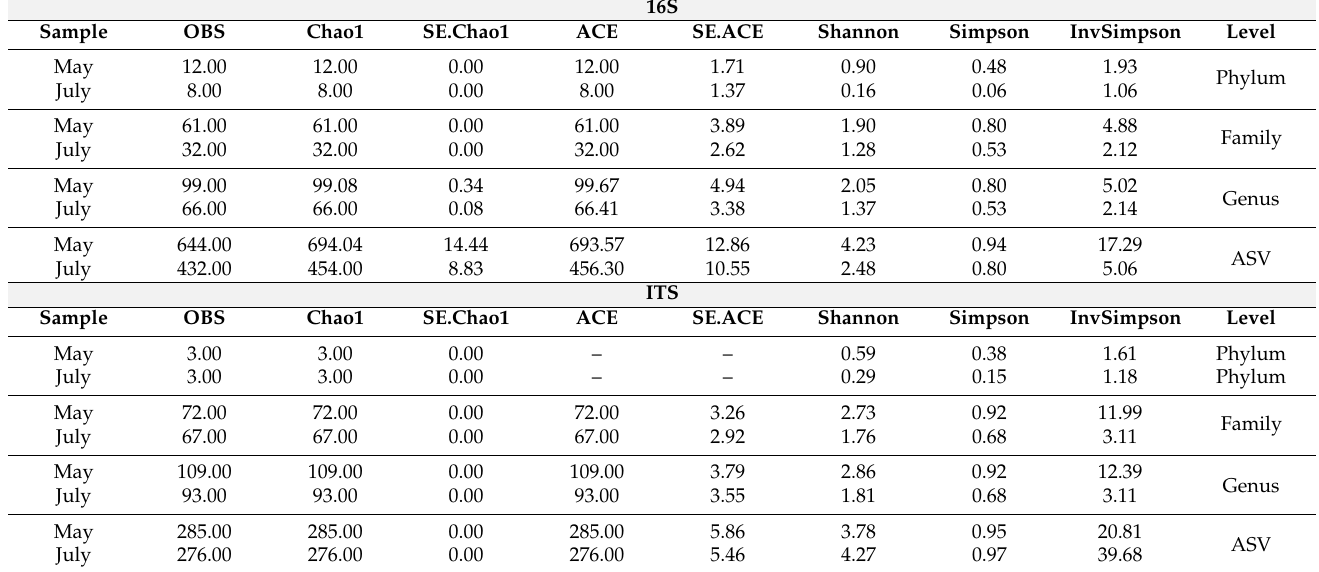
Table 3. Bacterial and fungal community richness and diversity of the ‘Williams’ pear variety at two phenological stages presented through alpha diversity indices at the phylum, family, genus, and ASV level. Richness is estimated by observed (OBS), Chao1, and ACE estimators, while diversity was evaluated by Shannon and Simpson